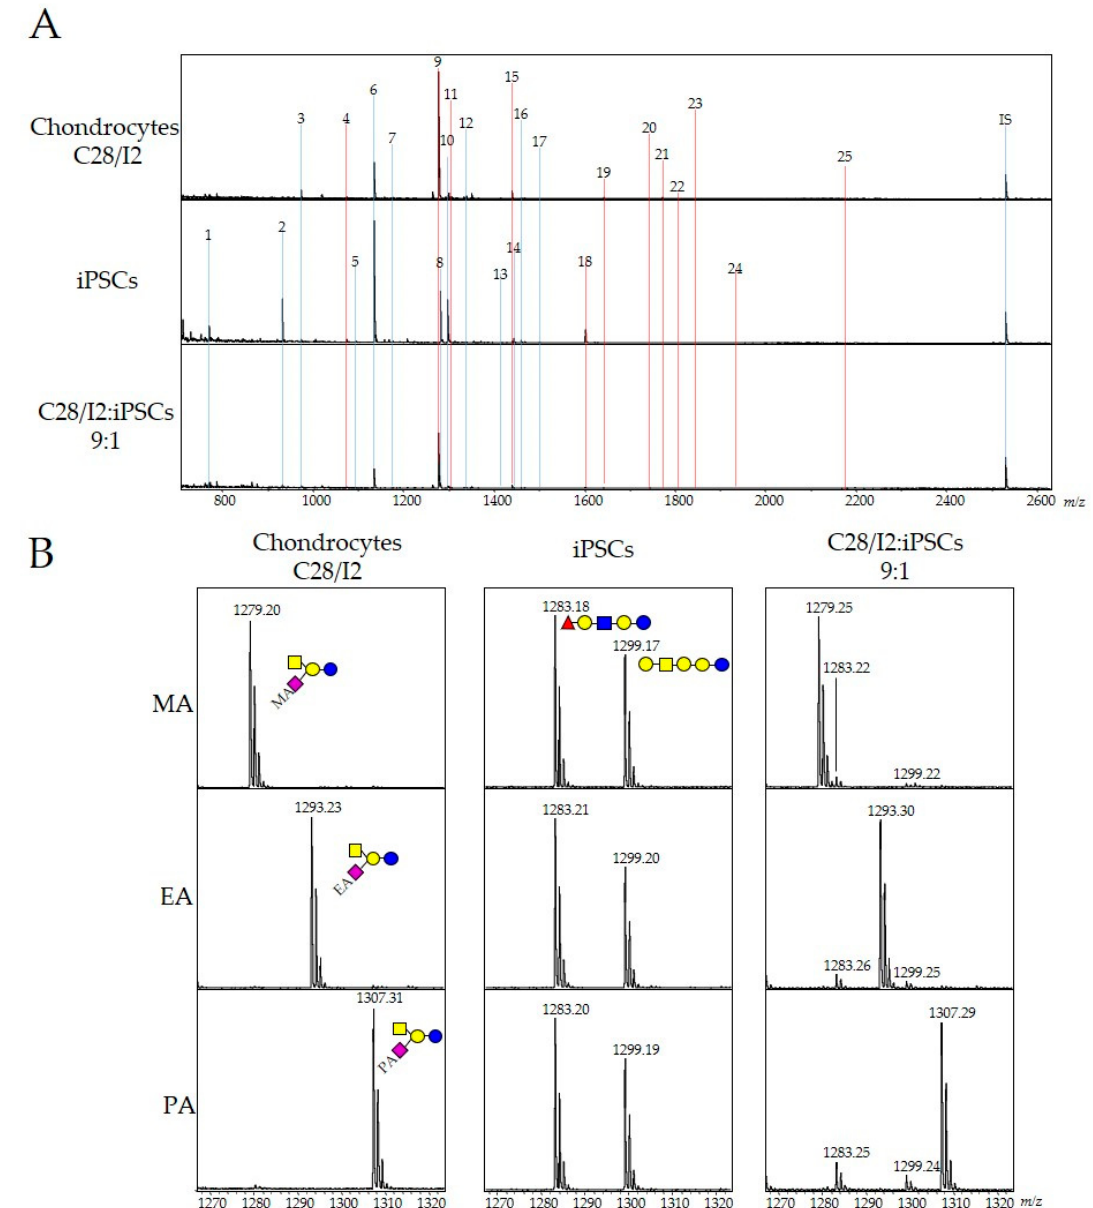
Figure 1. Analysis of GSL-glycans from iPSCs and chondrocytes using the aminolysis-SALSA method. ( A ) MALDI-TOF MS spectra of GSL-glycans in chondrocyte cells, iPSCs, and coexisting cells. ( B ) MALDI-TOF MS spectra of GSL-glycans from each cell type were acquired after derivatization with methylamine (MA), ethylamine (EA), or propylamine (PA) using the aminolysis-SALSA method, in the range of 1265 − 1325 m / z . The signal numbers correspond to those described in Table 1. Table 1. The glycan composition and quantitation of GSL-glycans in both chondrocytes and iPSCs. No.